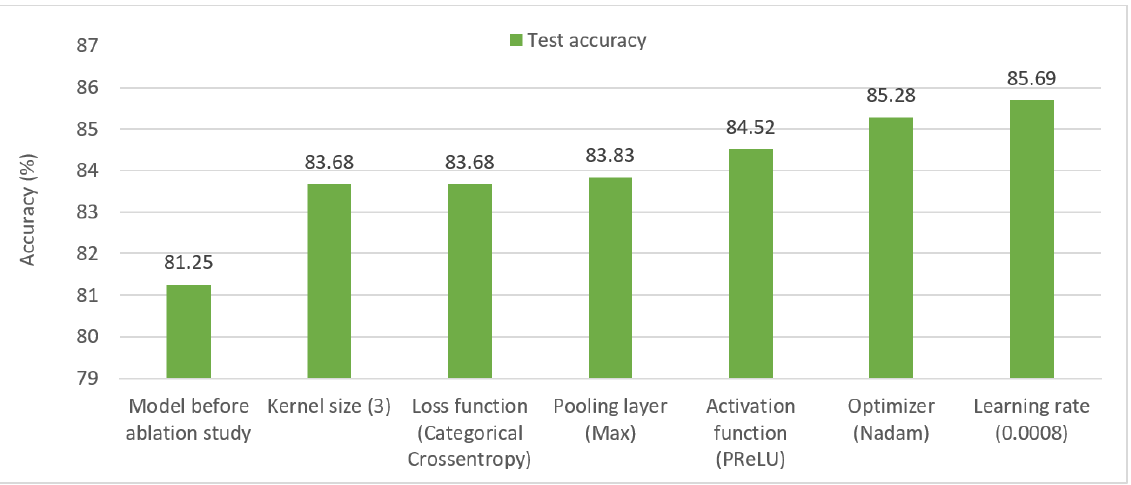
Figure 29. Gradual increase of test accuracy in various ablation studies.